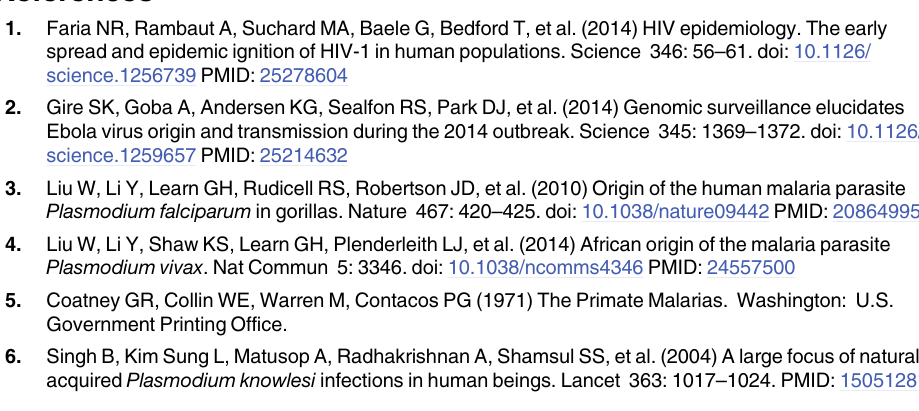
S3 Table. Numbers of P . knowlesi infections genotyped and allelic diversity in each popula- tion. S4 Table. Genotypic data of 10 pairs and one triplet of identical haplotypes detected in six geographical locations. S5 Table. Degree of local Cluster 1 and Cluster 2 mixedness and test of multi-locus disequi- librium of P . knowlesi in human infections sampled at 10 sites across Malaysia. S6 Table. Pairwise measures of fixation indices ( F ST values above diagonal) and geographi- cal distance (in kilometres below diagonal) across 10 populations of P . knowlesi from human infections. S1 Dataset. Genotypes at P . knowlesi microsatellite loci in infections from macaques (n = 47) and humans (n =